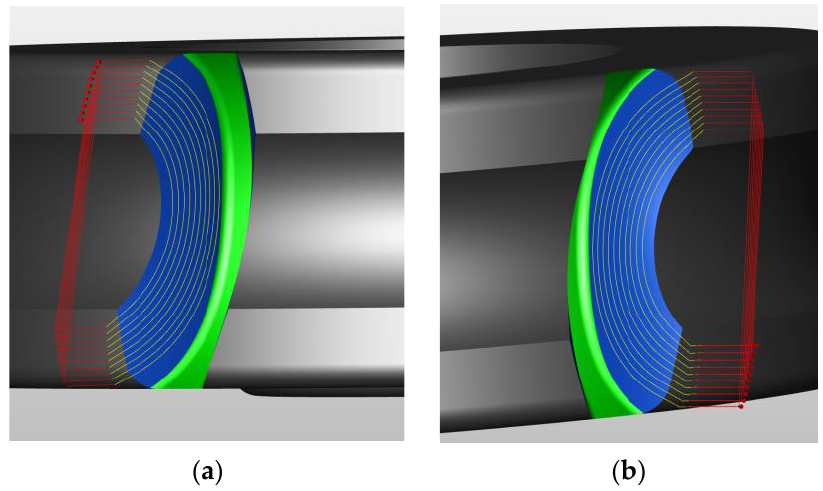
Figure 9. Milling pass of worm wheel through CAM process. ( a ) Right tooth flank ( b ) Left tooth flank.